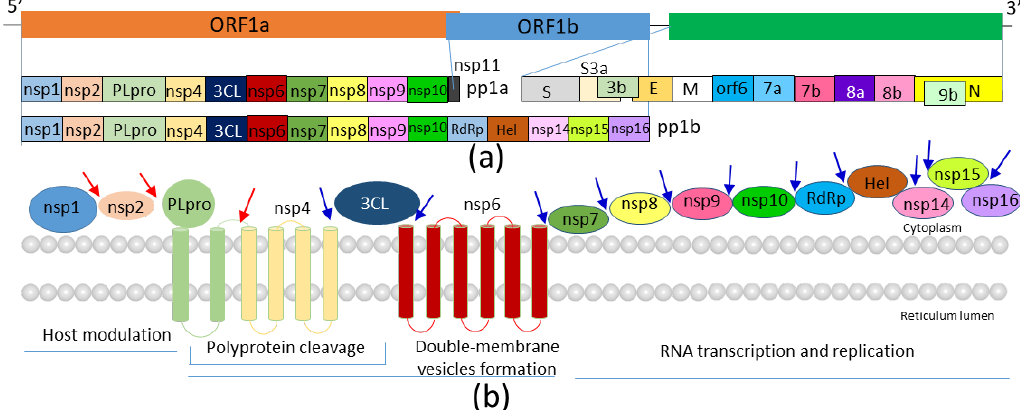
Figure 1. Genome of severe acute respiratory syndrome coronavirus 2 (SARS-CoV-2). ( a ) Viral proteins encoded by the viral genome. The nonstructural proteins (nsps), structural proteins, and accessory proteins (Orf3a to Orf9b) are shown. ( b ) Membrane topology of several nonstructural proteins. The transmembrane domains of proteins are shown as cylinders. Arrows indicate cleavage sites of: papain-like cysteine protease (PL pro ; red) and 3 chymotrypsin-like protease (3CL pro ; blue). Other nonstructural proteins are shown as spheres. The sphere has not been drawn to actual scale of individual proteins. More information can be obtained from https: // viralzone.expasy.org /